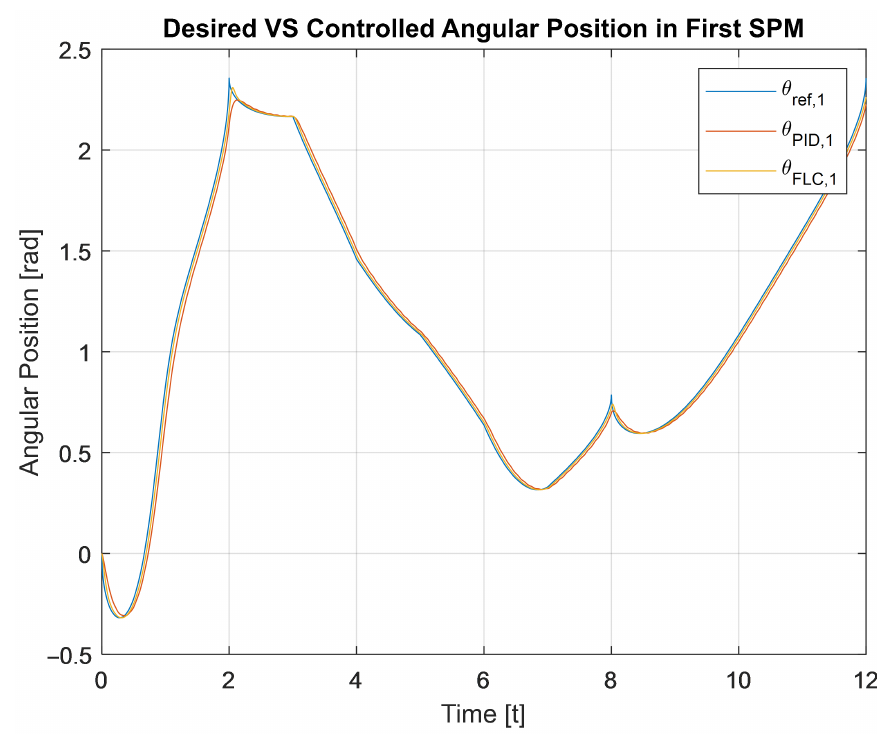
Figure 5. First joint trajectory tracking